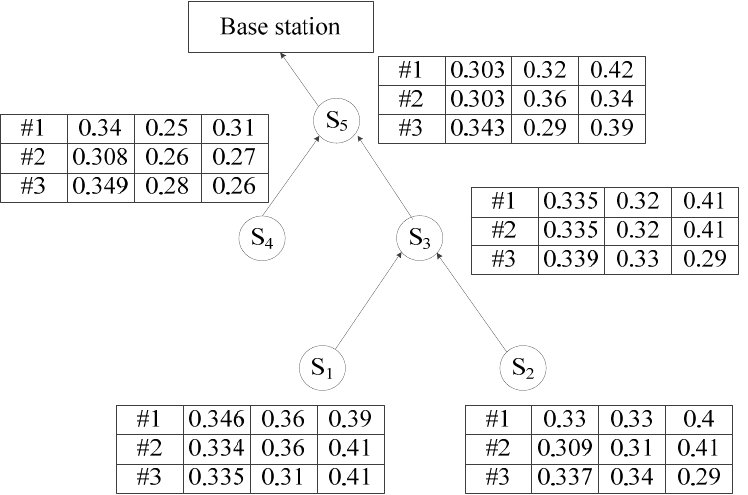
Figure 1. An example of a skyline query.